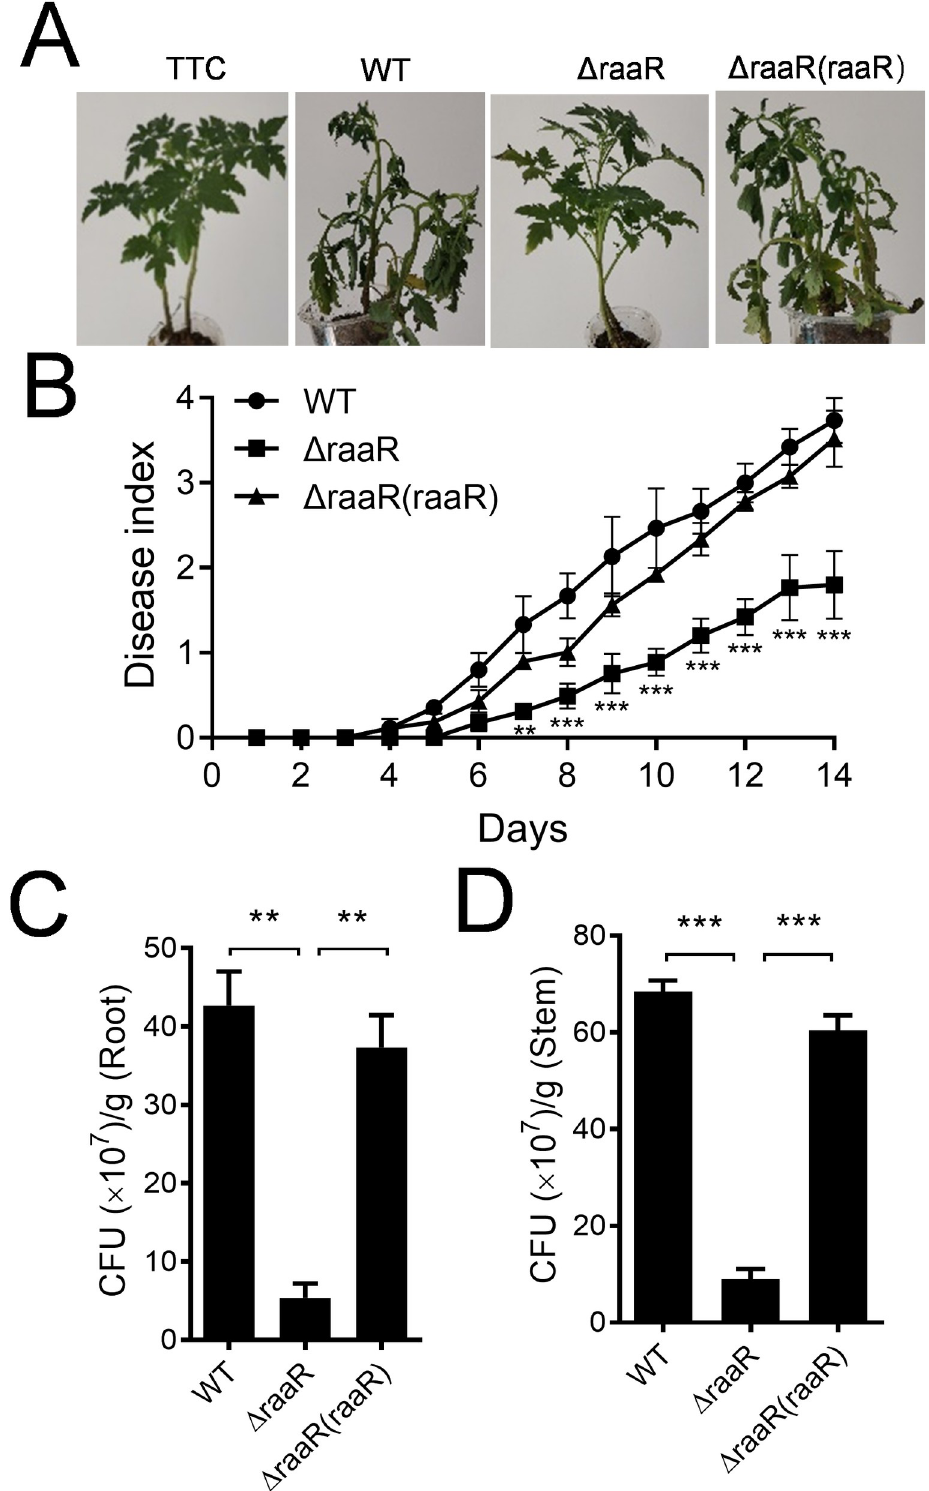
Fig 6. Influence of raaR on the pathogenicity of R . solanacearum in tomato plants. (A) Analysis of R . solanacearum virulence in tomato plants at 14 days after inoculation of R . solanacearum . (B) The effects of raaR on the virulence of R . solanacearum were measured by assessing the disease index of bacterial wilt in tomato. �� p < 0.01; ��� p < 0.001